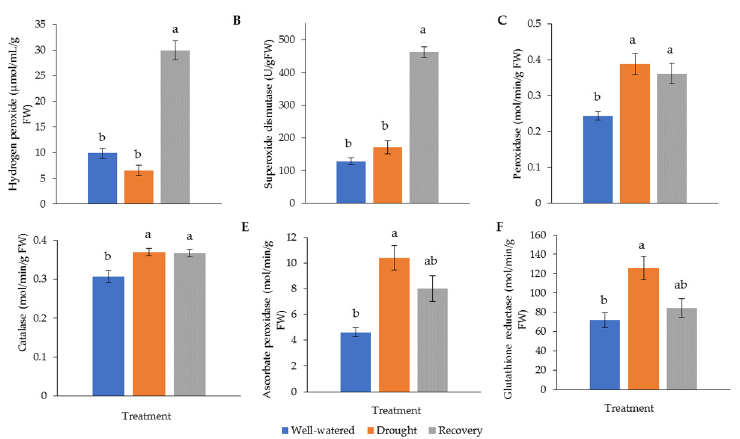
Figure 6. Activity of ( A ) hydrogen peroxide (H 2 O 2 ) and antioxidant enzymes, ( B ) superoxide dismutase (SOD), ( C ) catalase (CAT), ( D ) peroxidase (POD), ( E ) ascorbate peroxidase (APX), and ( F ) glutathione reductase (GR) in Pandanus amaryllifolius leaves in response to drought stress and water recovery. Absorbance was measured through a spectrophotometer. H 2 O 2 accumulation is shown in µ M min − 1 g − 1 fresh weight (FW), whereas SOD is shown as U g − 1 FW based on NBT coloration and inhibition. CAT, POD, APX, and GR are shown in M min − 1 g − 1 FW. Means labeled with alphabet were significantly different based on the ANOVA followed by post hoc when its p -value < 0.05.